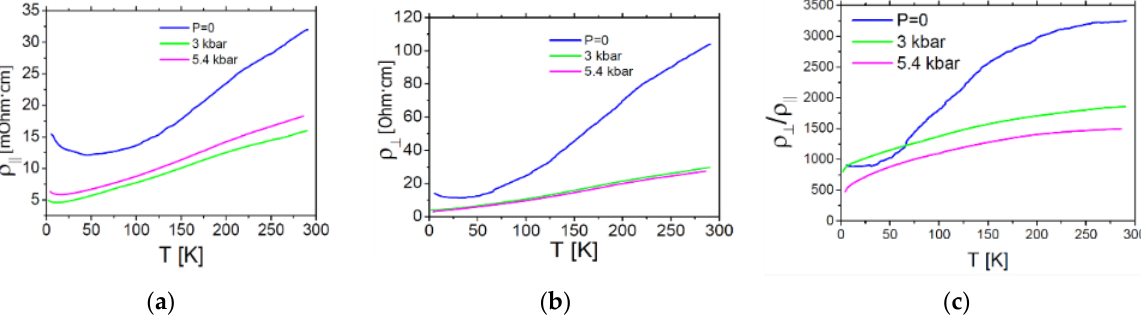
Figure 10. ( a ) Temperature dependence of the resistivity of the κ -(BDH-TTP) 4 ReF 6 sample ( 1 ) measured in the conducting plane and ( b ) perpendicular to it at different pressures; ( c )The temperature dependence of the resistivity anisotropy of ( 1 ).